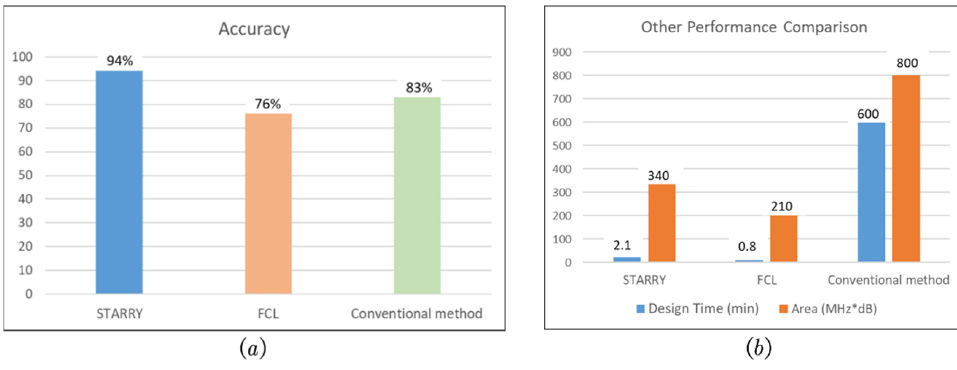
Figure 12. ( a ) Accuracy comparison ( b ) Other performance comparison.